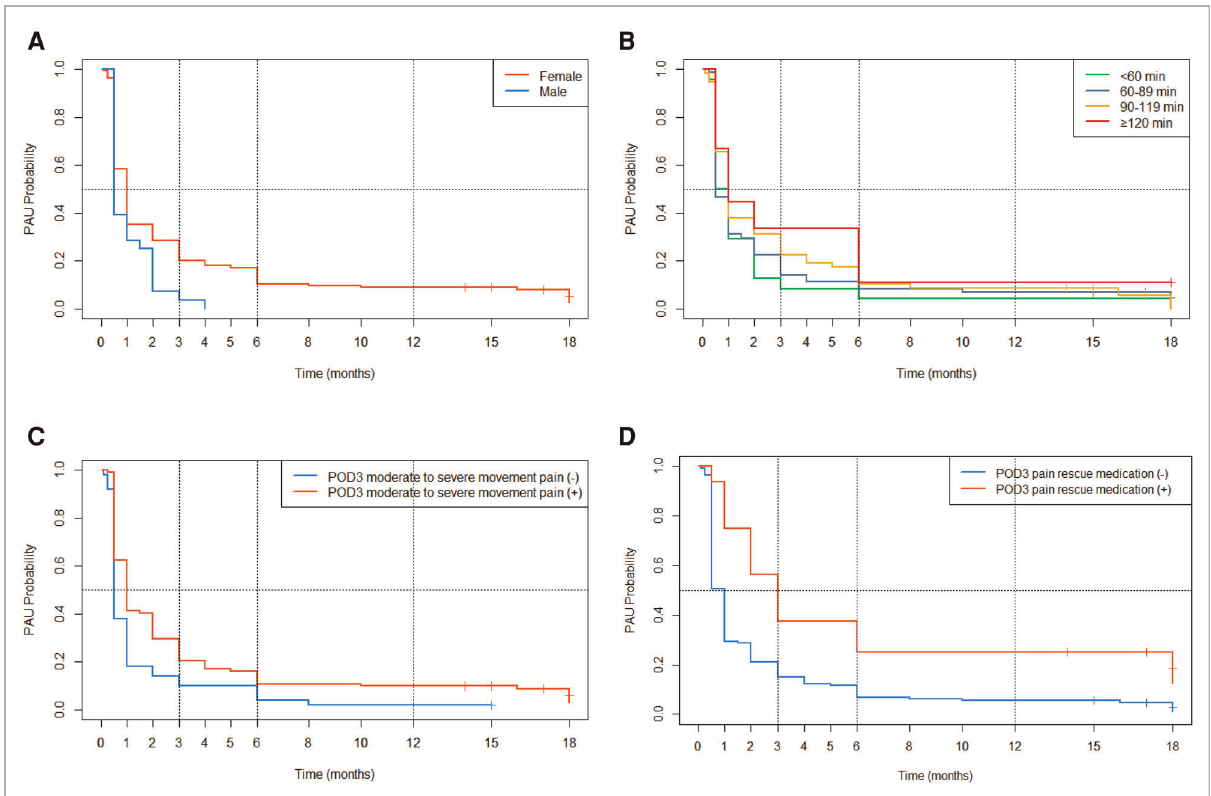
FIGURE 4 K-M survival curves for categorical data. ( A ) Gender; ( B ) duration of surgery; ( C ) POD3 moderate to severe movement pain ( D ) POD3 pain rescue